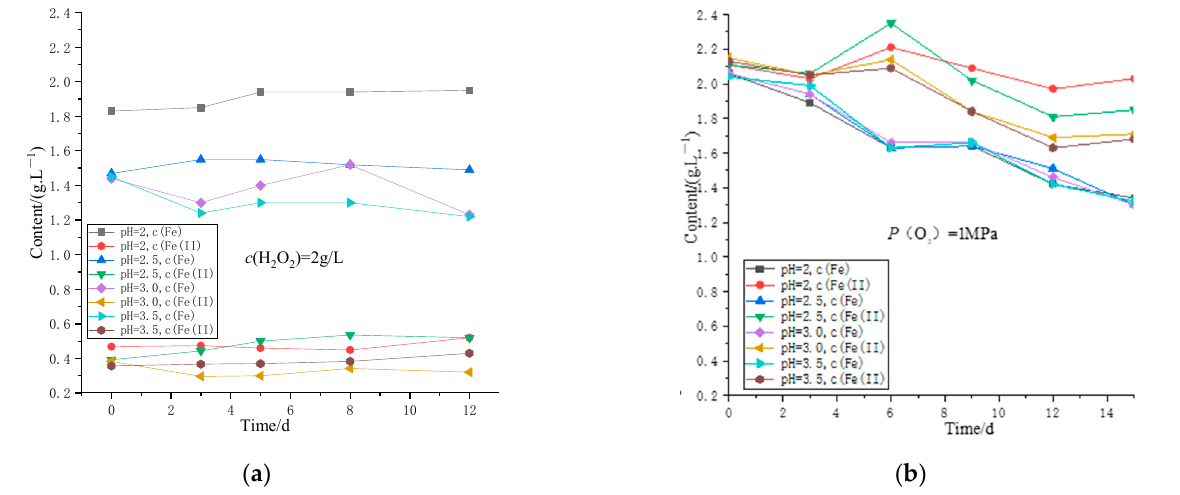
Figure 2. Oxidizing effect of oxidant on Fe(II) under different pH conditions. ( a ) shows the use of hydrogen peroxide. ( b ) shows the use of oxygen.